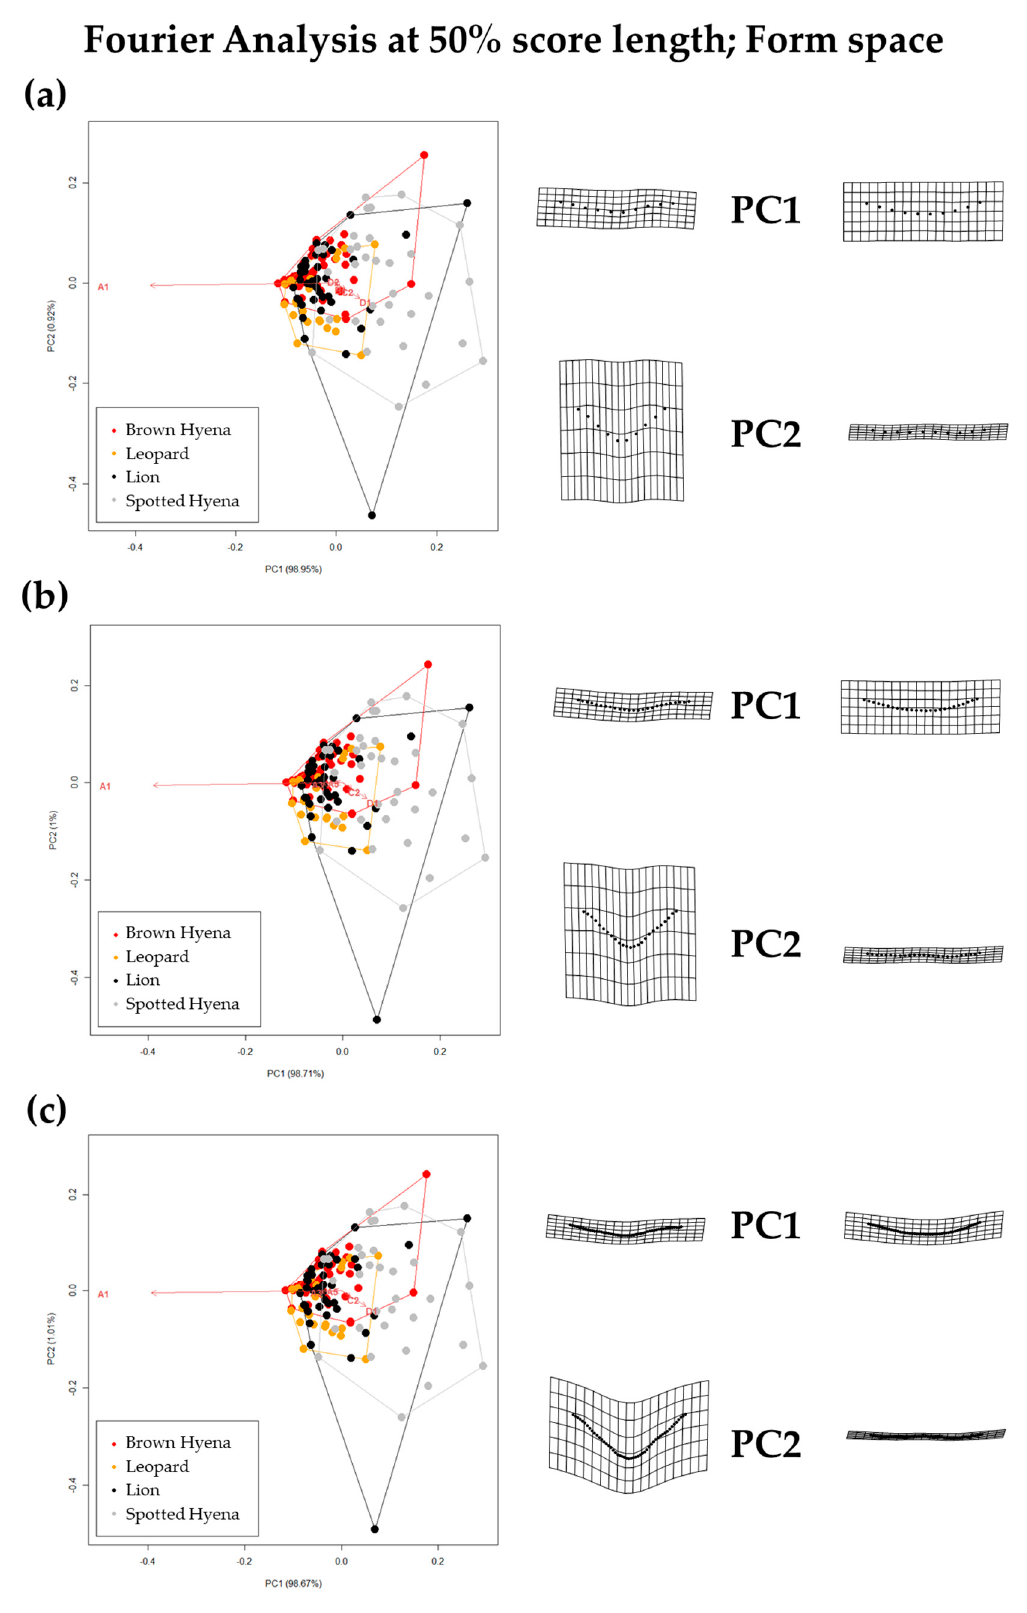
Figure 5. Form PCA plots on Elliptic Fourier Analysis on the single-curve semilandmark models at 50% cross-sectional score length, using ( a ) 10 points; ( b ) 25 points; and ( c ) 50 points. Extreme changes in form along PC1 and PC2 are illustrated with the aid of transformation grids. Optimal harmonics for each model are ( a ) 2; ( b ) 6; and ( c ) 6.